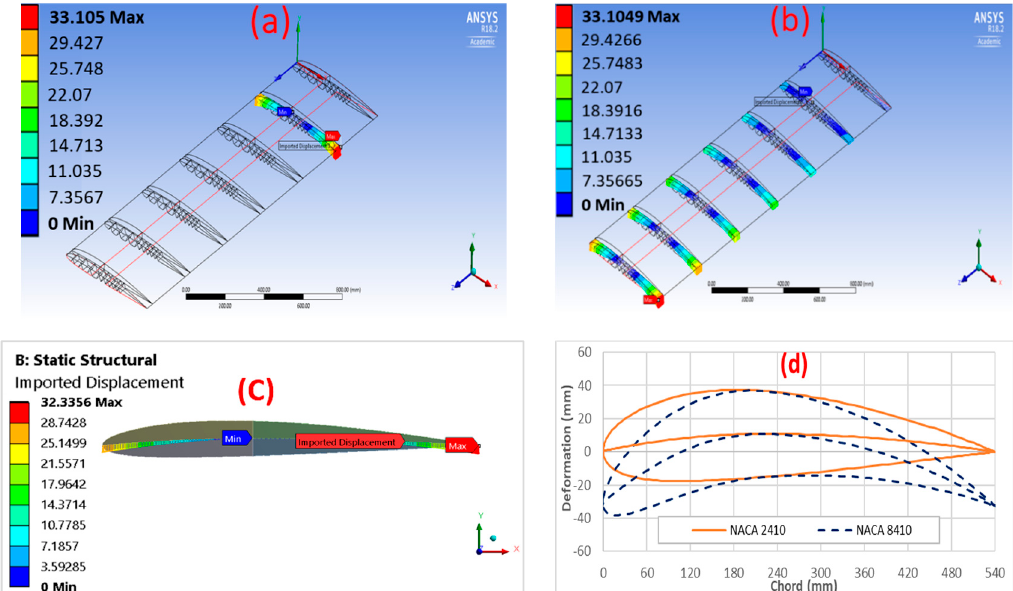
Figure 4. Wing morphing cases, ( a ) step morphing displacement input; ( b ) linear morphing displacement input; ( c ) input displacement profile applied on one actuator (step morphing case); ( d ) 2D airfoil comparison between NACA2410 and NACA8410. Table 2. Wing boundary conditions and their perspective